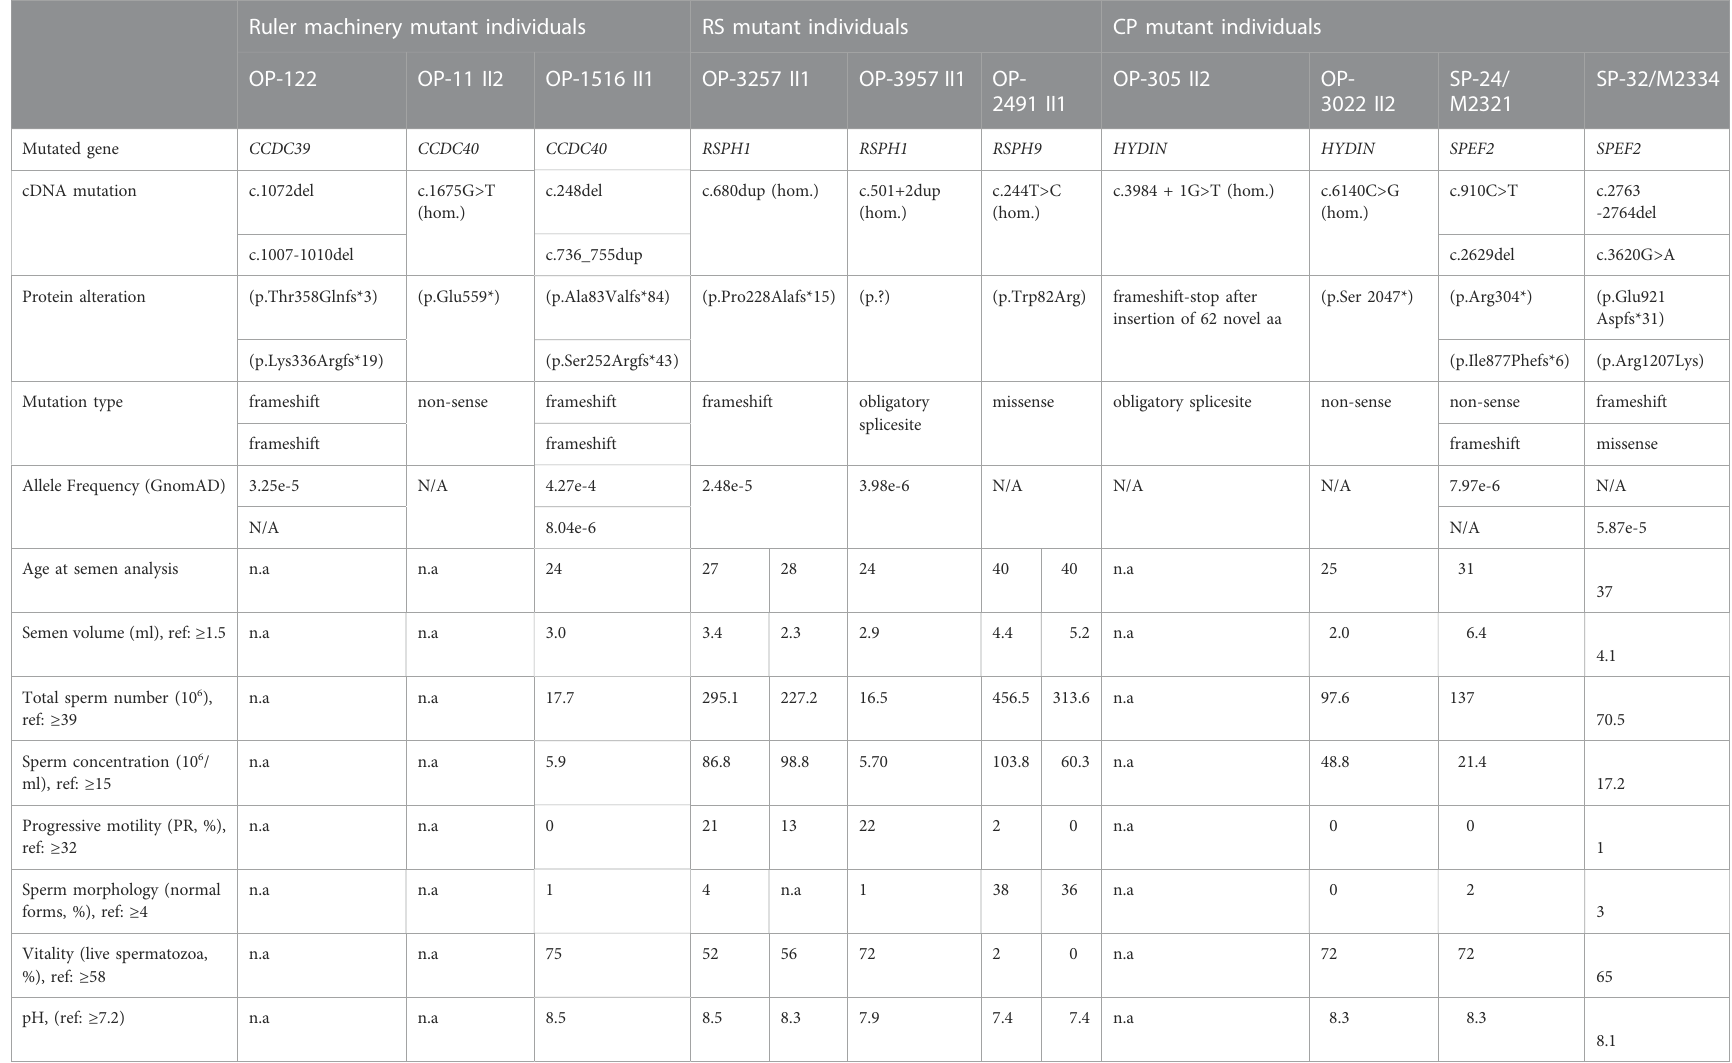
TABLE 1 Clinical characteristics of study participants. aa: amino acids; Chron: chronic; del: deletion; dup: duplication; FEV: forced expiratory volume; hom: homozygous; ml: milliliter; N/A: not annotated; n.a: not available; nl: nanoliter; nNO; nasal nitric oxide-production rate; RDS: respiratory distress syndrome, ref: reference